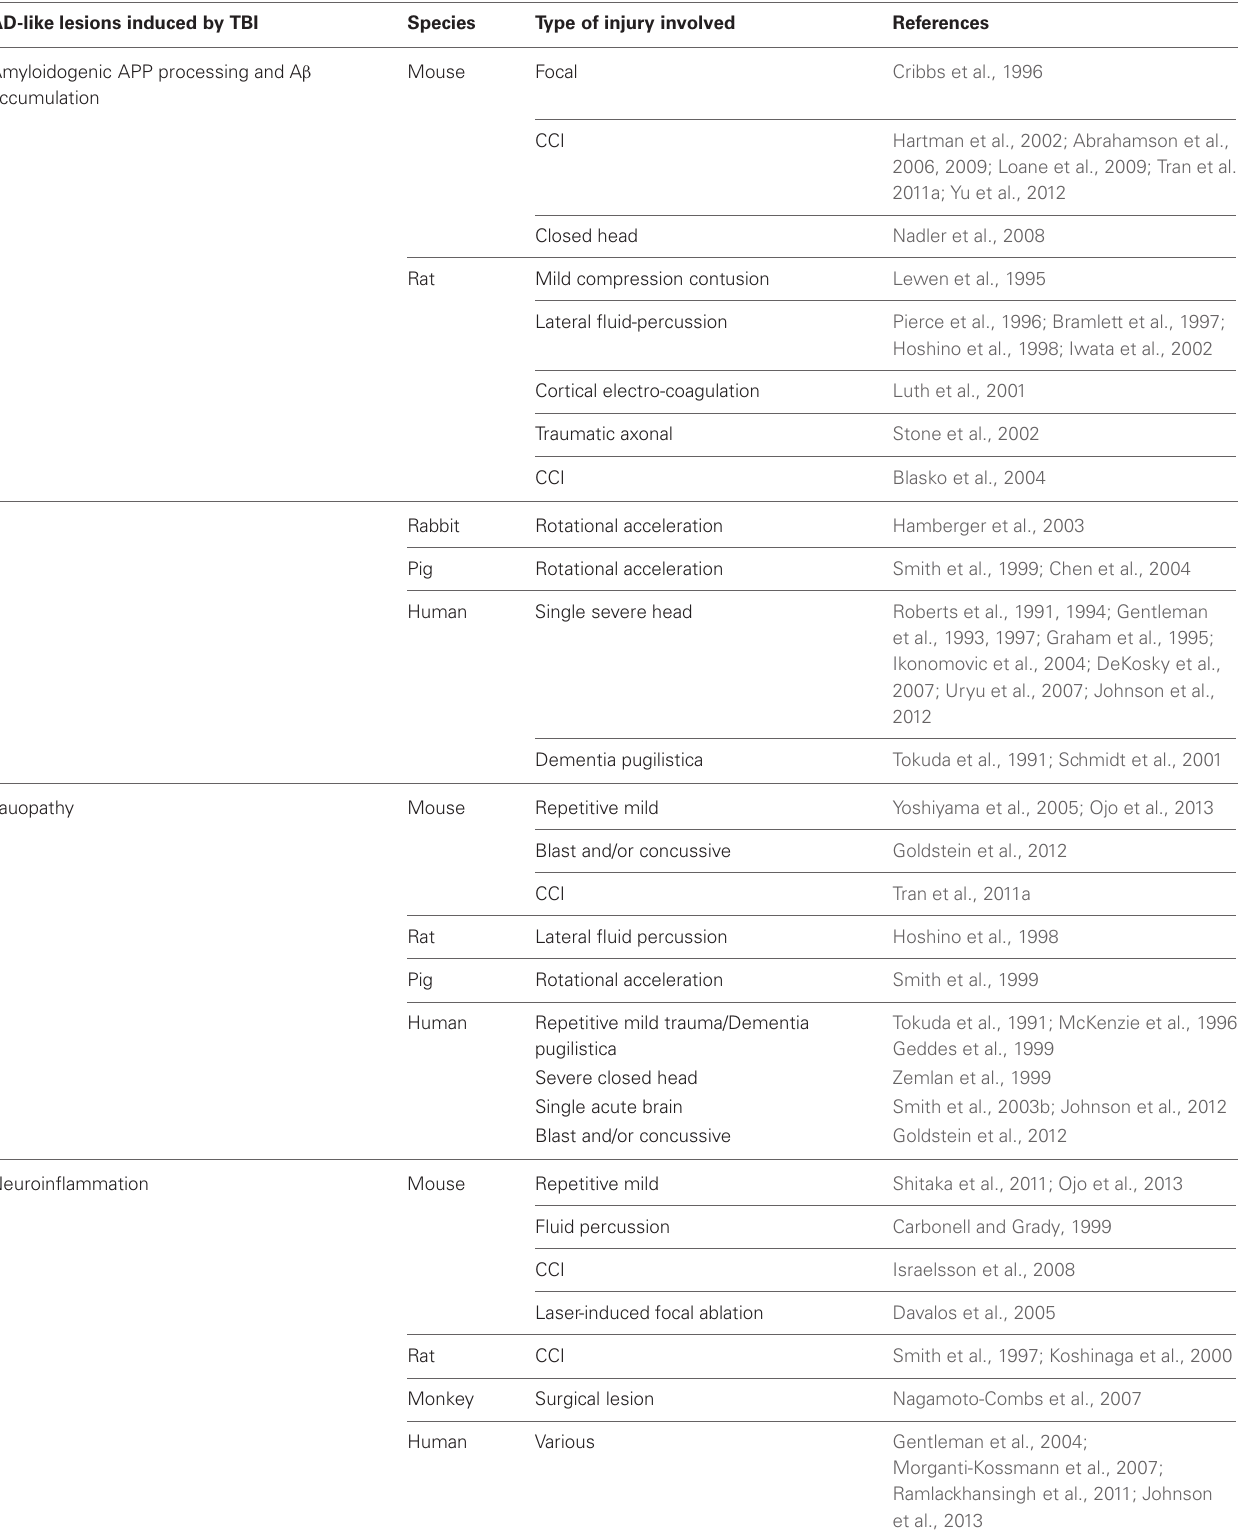
Table 1 | Alzheimer’s disease-type lesions induced by various TBIs in humans and in animal models. AD-like lesions induced by